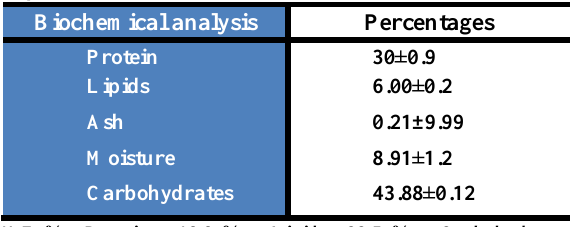
Table, 2: Percentages of biochemical analysis of experimental fish diet.